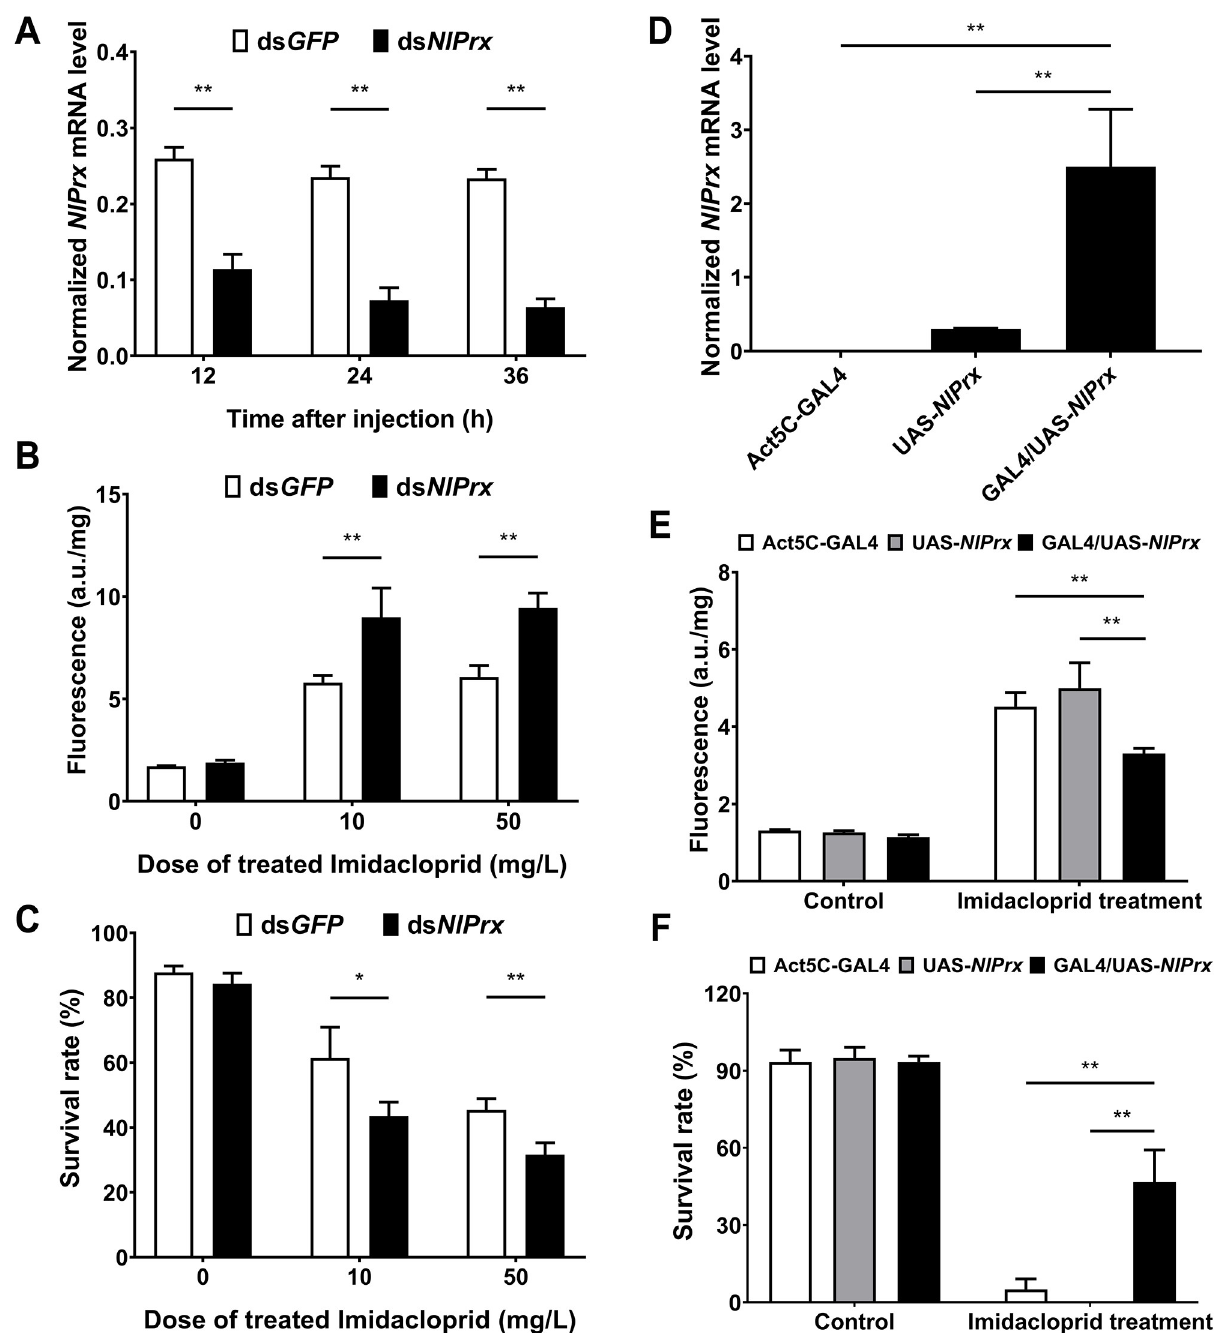
Fig 5. Impacts of RNAi-mediated knockdown and heterologous expression of NlPrx on the ROS levels and survival rates of R-P adults of N . lugens or the GAL4/UAS- NlPrx progeny line of D . melanogaster . (A) Time course of the expression level of NlPrx in R-P adults injected with ds GFP (control) or ds NlPrx . (B) Impacts of 10 or 50 mg/l imidacloprid on the ROS levels of R-P adults pre-injected with ds GFP (control) or ds NlPrx . (C) Impacts of 10 or 50 mg/l imidacloprid on the survival rates of R-P adults pre-injected with ds GFP (control) or ds NlPrx . (D) qRT-PCR detection of NlPrx transcripts in the GAL4/UAS- NlPrx progeny line, UAS- NlPrx transgenic line, and Act5C-GAL4 driver line of D . melanogaster . (E) Impacts of 30 mg/l imidacloprid on the ROS levels of the GAL4/UAS- NlPrx progeny line, UAS- NlPrx transgenic line, and Act5C-GAL4 driver line of D . melanogaster . (F) Impacts of 30 mg/l imidacloprid on the survival rates of the GAL4/UAS- NlPrx progeny line, UAS- NlPrx transgenic line, and Act5C-GAL4 driver line of D . melanogaster . The R-P adults injected with ds NlPrx or ds GFP were exposed to different doses (0, 10, or 50 mg/l) of imidacloprid 24 h after injection of dsRNA. The ROS levels and survival rates of these adults and the 3 lines of D . melanogaster were measured 24 and 48 h after exposure to imidacloprid, respectively. All data shown are mean ± SD of 3 biological replicates ( n � 3). Extremely significant ( P < 0.01) and